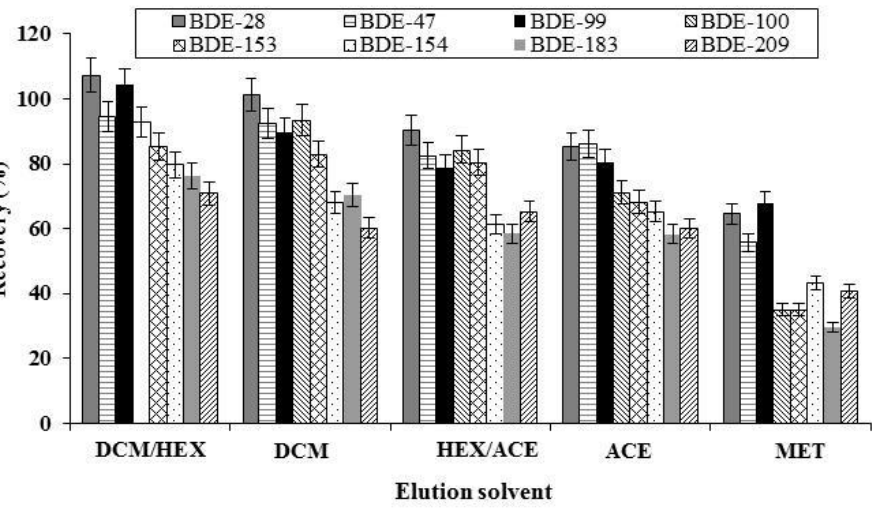
Figure 3. Effect of different elution solvents on extraction recoveries of PBDEs ( n = 3).